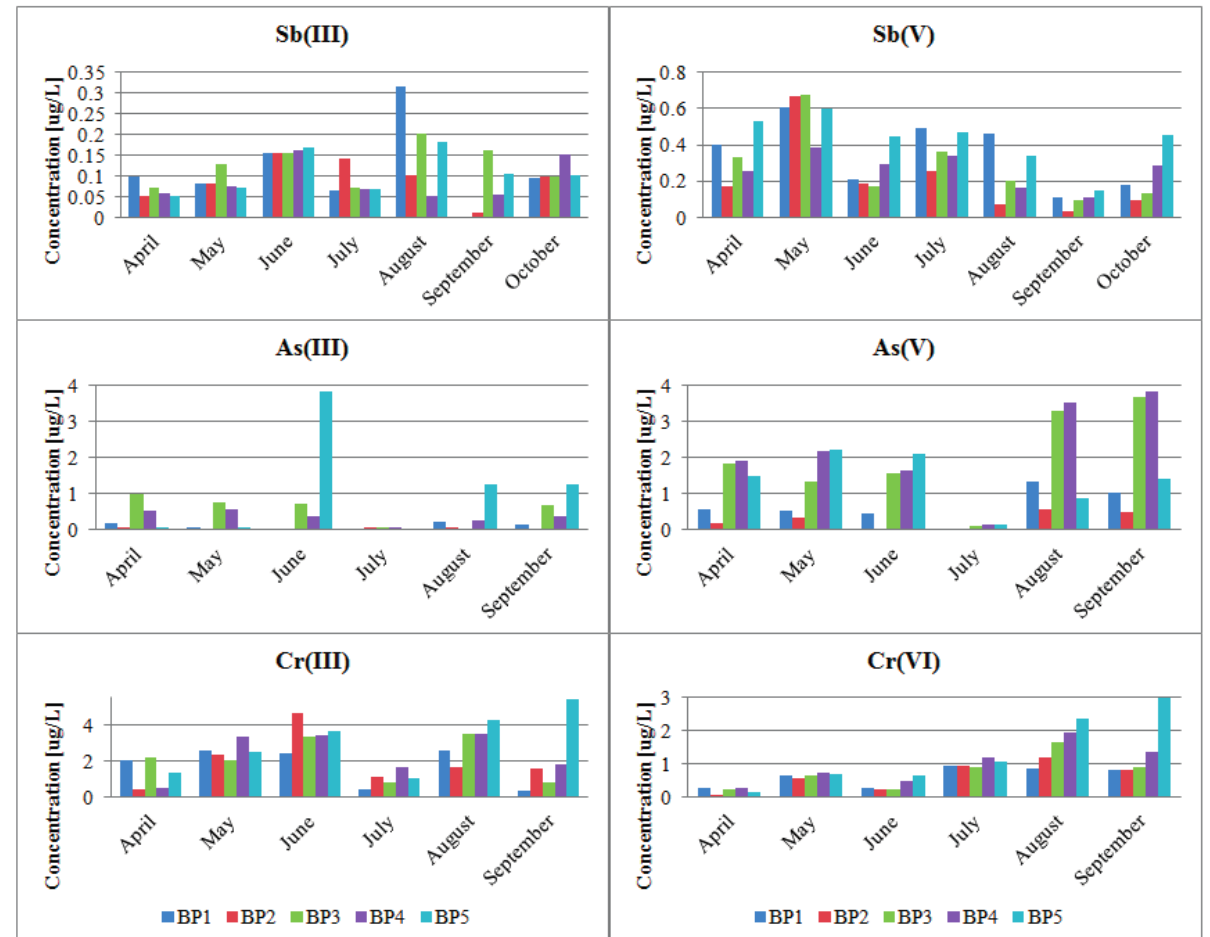
Figure 8. Concentrations of Sb(III)/Sb(V), As(III)/As(V) and Cr(III)/Cr(V) in the Bia ł a Przemsza River water; sampling points: BP1—Chrz ą stowice; BP2—Klucze Osada; BP3—D ą browa Górnicza Okradzionów; BP4—S ł awków;